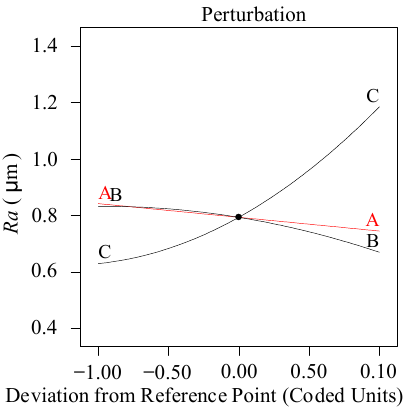
Figure 8. Perturbation diagram ( Ra ).